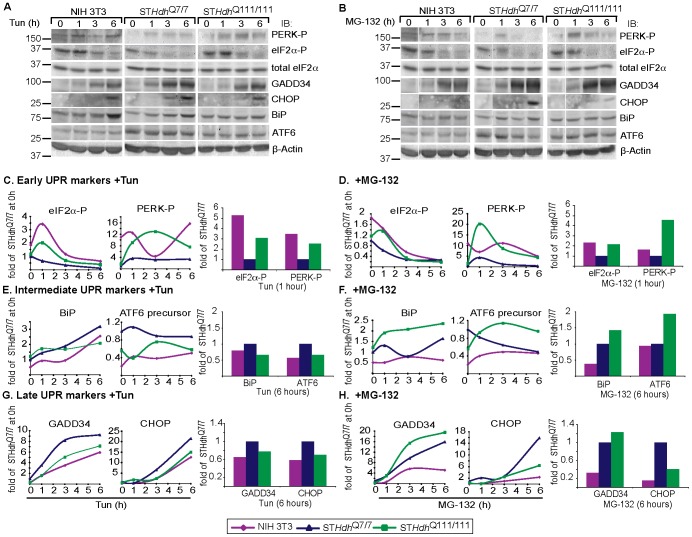
Striatal neurons show a low induction of early UPR markers, whereas later ER stress responses are upregulated.Early responses and in some cases late ones are increased by expression of Htt111Q. A,B) Levels of UPR markers after short term ER stress. STHdh
Q7/7 were compared to STHdh
Q111/111 and NIH 3T3 cells. Immunoblots show results of a representative experiment of 3. Vertical lines indicate removal of irrelevant lanes. C-H) Quantification of A,B. STHdh
Q7/7 cells do not activate properly an early stress response, mediated by PERK-P and its target eIF2α-P, induced by Tun (C, 10 µg/ml) or by MG-132 (D, 40 µM). In STHdh
Q111/111 cells, PERK-P and eIF2α-P are induced (C,D). Later ER stress responses are increased in STHdh
Q7/7 compared to NIH 3T3 cells (E-H). Htt111Q expression causes even more enhanced upregulation of the UPR markers in some cases. Values were normalized to β-actin levels as a loading control.